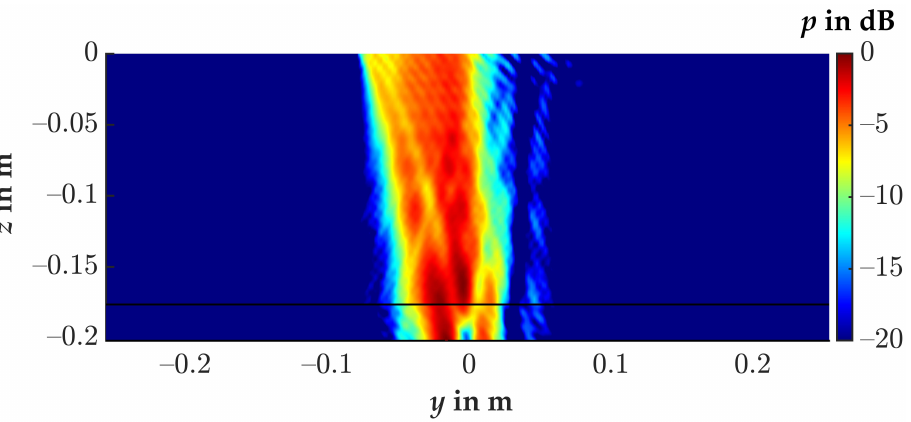
Figure 12. Cross-section plane at x = 0 m of the calculated volume with the ø10 mm flaw. The sound pressure is shown in dB. For the color scaling in the air, the maximum of the sound pressure in the air volume is taken up to the surface of the particleboard ( z = 0 m to − 0.177 m). For the color scaling in the particleboard, the maximum sound pressure in the particleboard ( z = − 0.178 m to − 0.202 m) is used. If both are now displayed up to − 20 dB, the result is a matching color scale. The results were evaluated at a frequency of 50